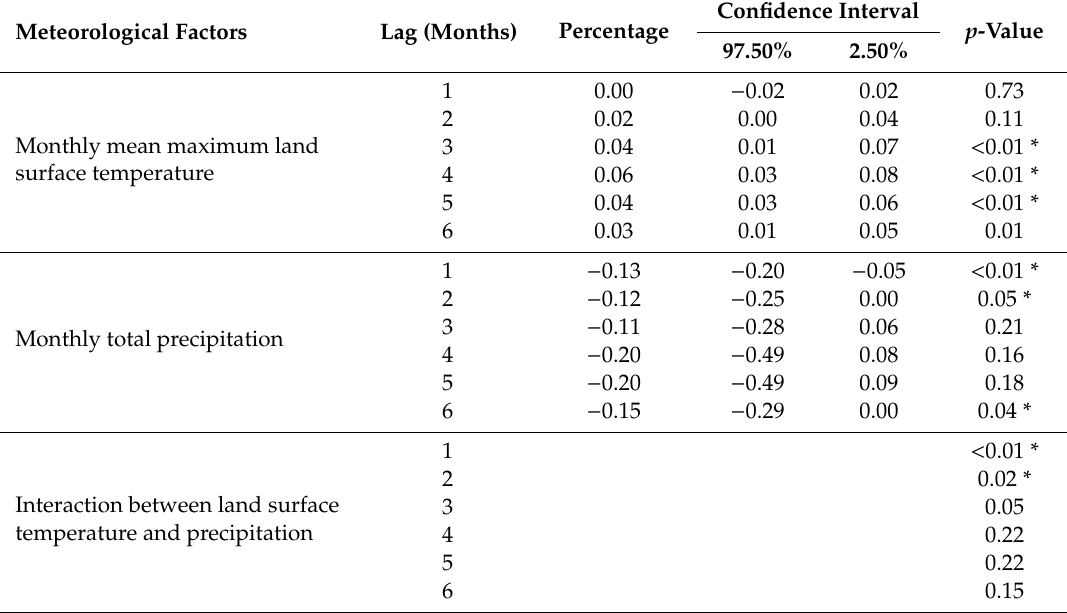
Table A1. Percent change of VL events associated per unit increase of land surface maximum temperature and